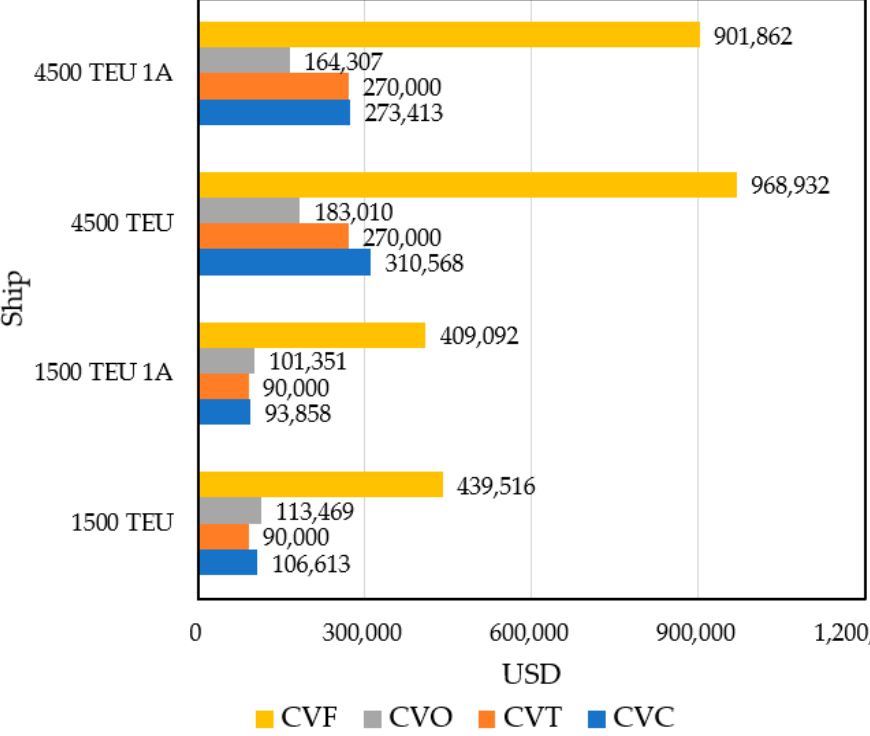
Figure 9. Voyages cost analysis for Americas sea route and the Northwest Passage.